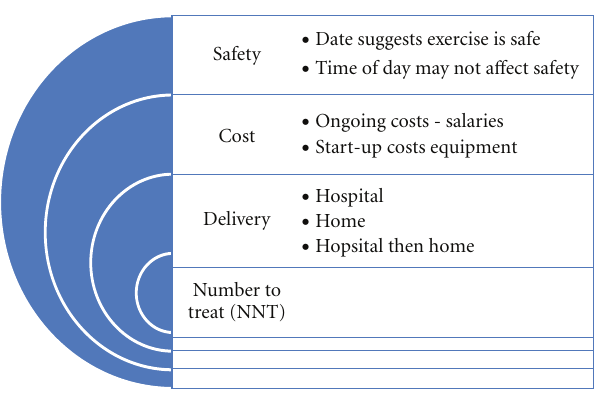
Figure 4: Public health issues associated with exercise training programs for heart failure